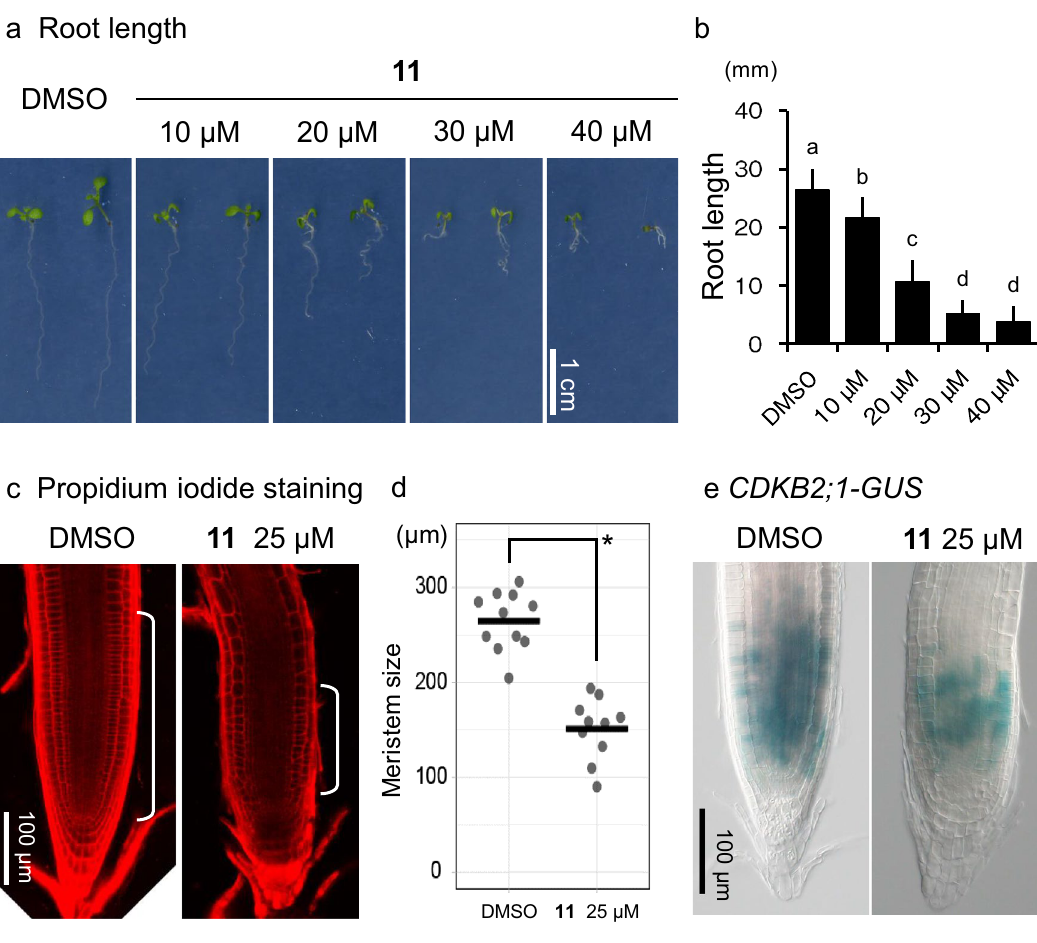
Figure 4. Analysis of the inhibitory effect on growth of the kumamonamic acid derivative, kumamonamic acid nonyloxy derivative (KAND). ( a ) Seven-day-old, wild-type Col seedlings were grown on MS plates with the indicated concentrations of KAND 11 . Scale bar = 1 cm. ( b ) Quantification of the root length. Letters indicate significant differences (Tukey’s HSD test, p < 0.05). n > 16. Data are shown as average ± SD. ( c ) Confocal microscopy of propidium iodide-stained wild-type Col roots grown on MS plates with or without 25 μM KAND 11 . White brackets indicate root meristem. Scale bar = 100 μm. ( d ) Quantification of the root meristem size (n = 10 to 11). Statistical differences were determined by t -test (p < 0.05). Bars indicate mean meristem size. ( e ) Differential interference contrast (DIC) microscopy of root meristems containing CDKB2;1pro:CDKB2;1- GUS constructs, Five-day-old seedlings grown on MS plates with or without 25 μM KAND were stained and